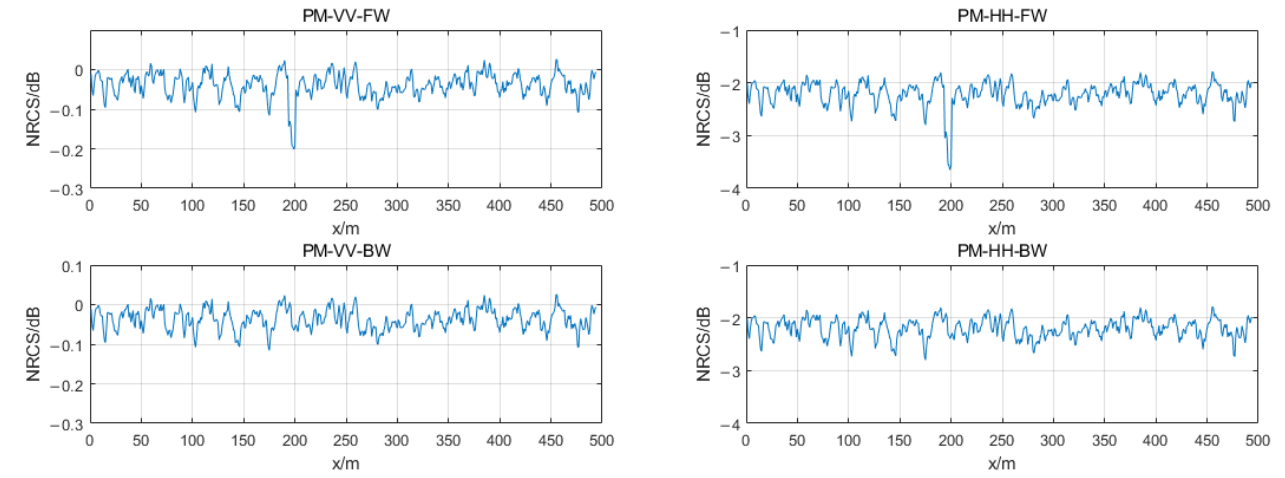
Figure 9. Comparison of NRCS results of freak wave (FW) and its background wave (BW) simulated by PM spectrum under VV polarization and HH